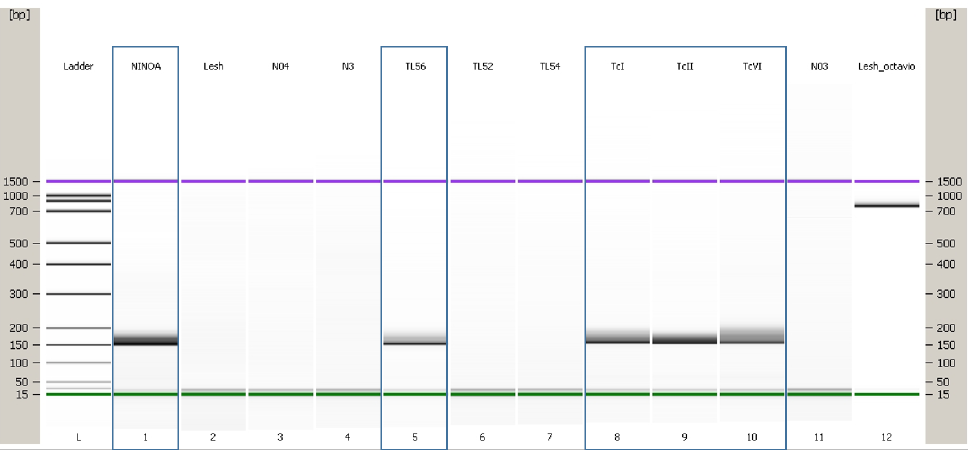
Figure 7. L = Ladder; 1. positive control NINOA (local); 5. TL56 (sample CAIMTriTp0009- T. yelapen- sis , positive); 8, 9, 10. TcI, II, and IV (cortesy of Dr. Bianca Zingales, Sao Paulo University, Brazil). Experiment performed in Agilent 2100 Bioanalyzer system